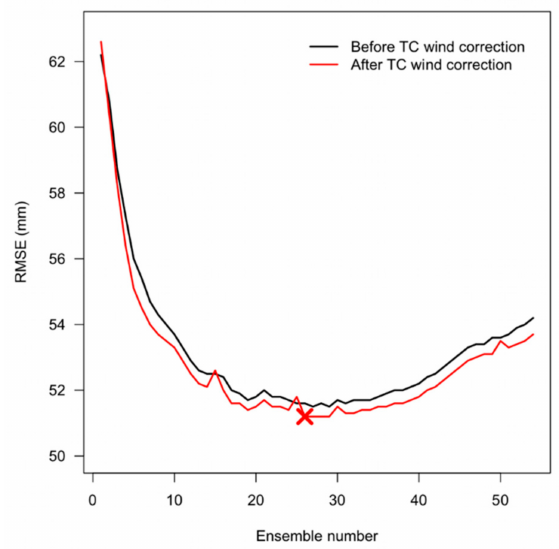
Figure 4. A comparison of the change in the RMSE of the prediction obtained with the increasing number of ensemble typhoons used before (black line) and after (red line) TC wind intensity correction. “X” represents the optimal ensemble number after TC wind intensity